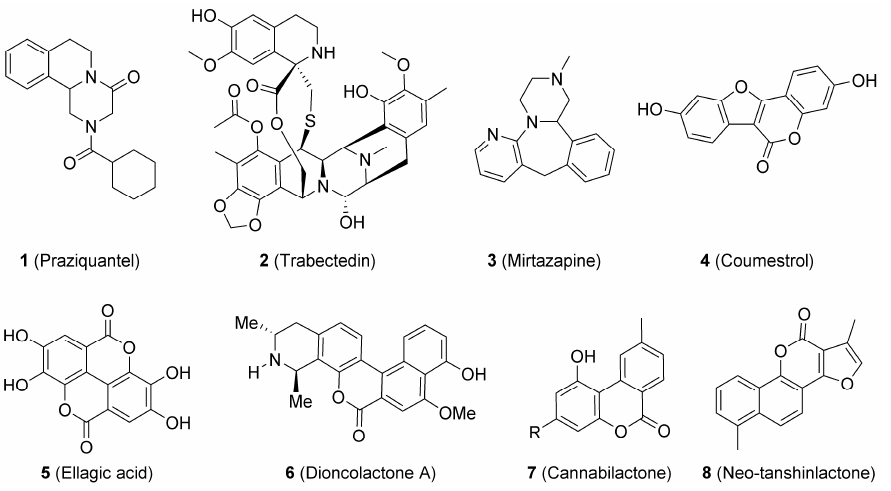
Figure 1. Some bioactive polycyclic pyrazines and coumarins.